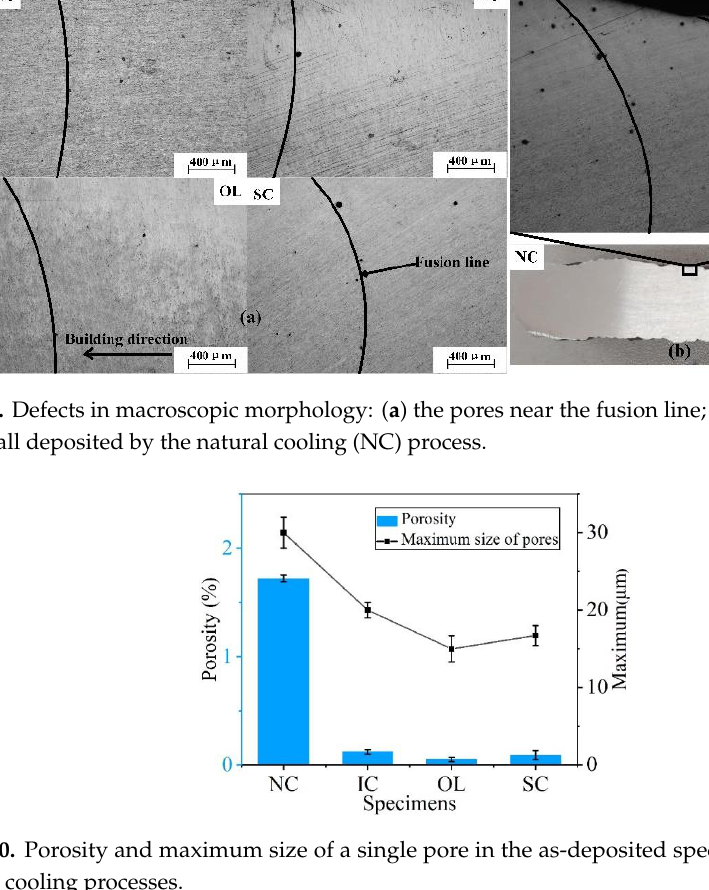
Figure 10. Porosity and maximum size of a single pore in the as-deposited specimens deposited by different cooling processes.